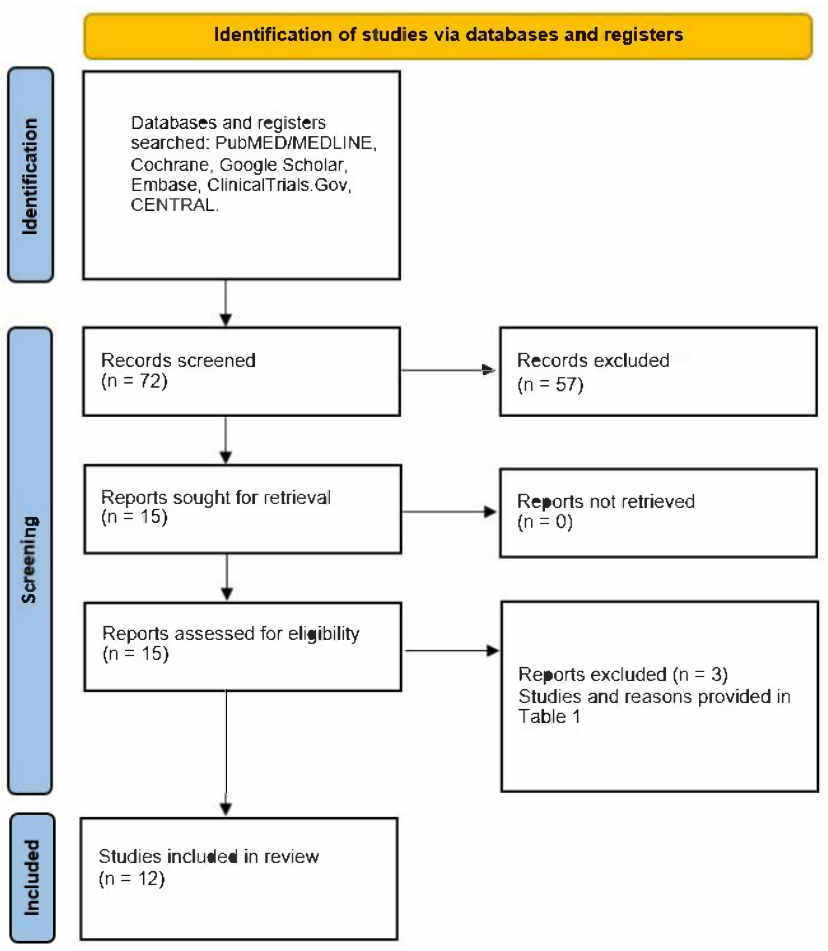
Figure 1. PRISMA flow diagram of the search methodology employed for this review.